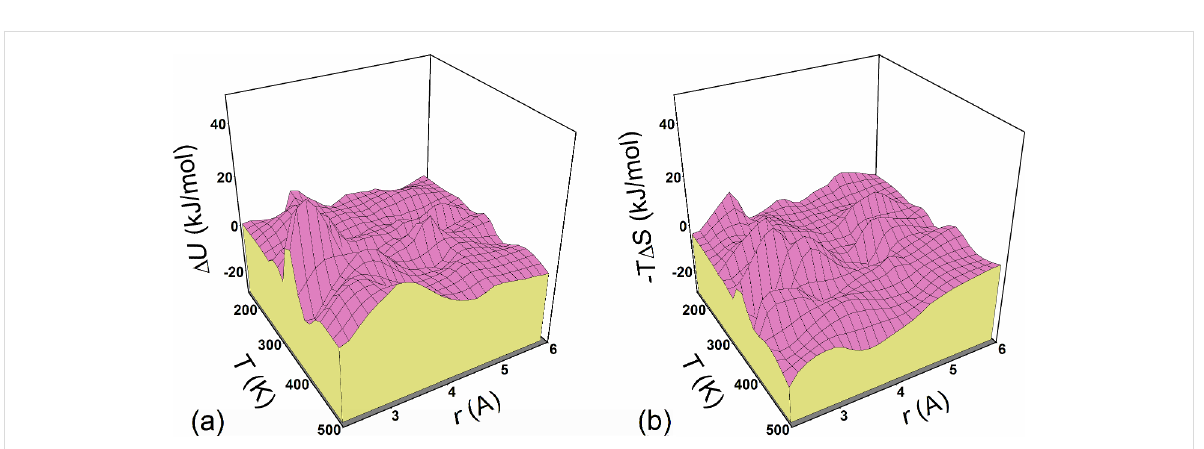
Figure 8: The surfaces (a) Δ U ( r , T ) and (b) – T Δ S ( r , T ) calculated for the region 2.2 < r < 6 Å via the separation of the potential of mean force W +– ( r ).